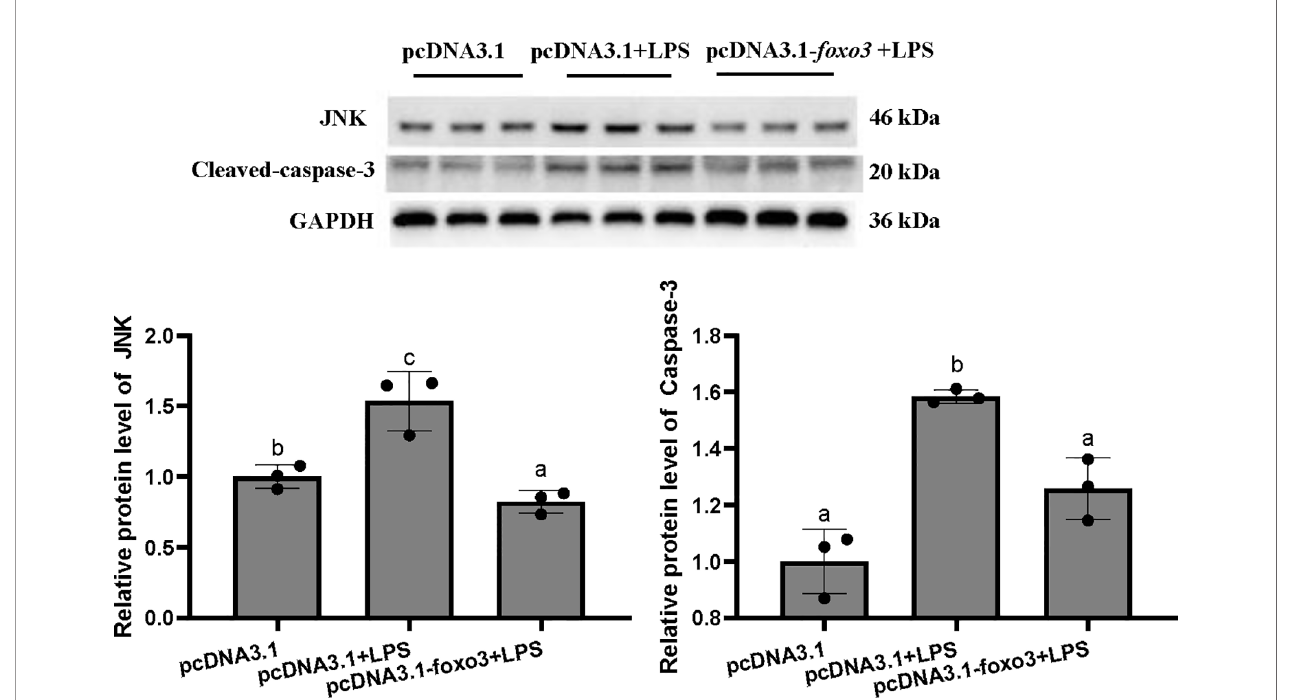
FIGURE 10 | Protein levels in turbot hepatocytes. The relative protein abundances of JNK and cleaved- caspase-3 in hepatocytes were measured by western blot and expressed as relative expression values to those in pcDNA3.1 group. Values are represented as means the mean ± standard deviation (n = 3). Values with different letters mean signi fi cantly difference ( P <